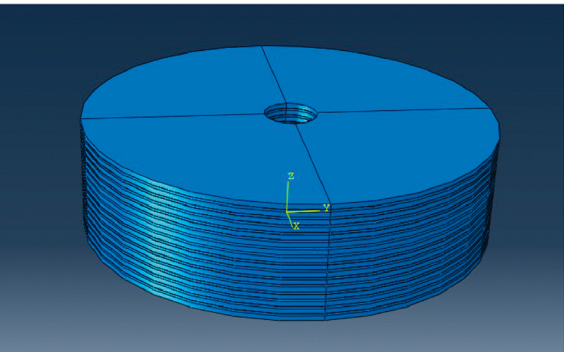
Figure 20: Geometric model of LNR500 in ABAQUS. Table 2: Relationship between stress and plastic strain in steel. Real stress (MPa)